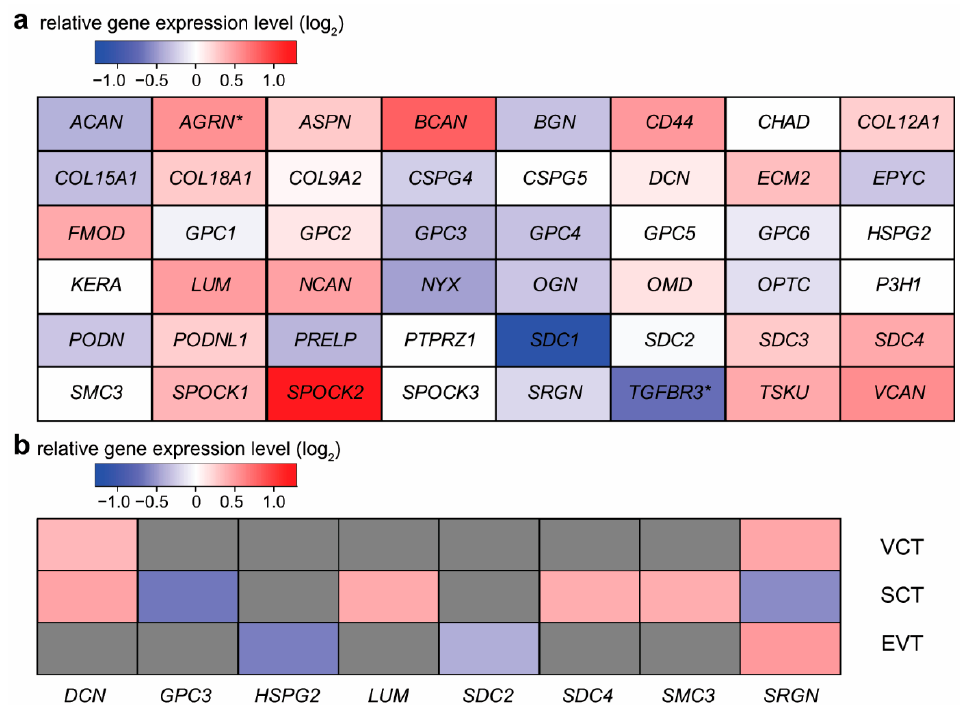
Figure 6. Placental proteoglycan gene expression in pre-eclampsia. ( a ) Placental microarray data from women with early-onset pre-eclampsia (n = 12) and preterm controls (n = 5) were published by Than et al. [51]. Color code depicts log 2 gene expression ratios between cases and controls. Red indicates higher gene expression, while blue depicts lower gene expression in pre-eclampsia. Stars show significant differences. ( b ) Single-cell RNA-seq data from women with early-onset pre- eclampsia and preterm controls were published by Zhang et al. [70]. Differentially expressed genes in villous cytotrophoblasts (VCT), in the syncytiotrophoblast (SCT), and in extravillous trophoblasts (EVT) were visualized on a heatmap. Red indicates higher gene expression, blue depicts lower gene expression in pre-eclampsia (log 2 fold change, q-value < 0.05), and grey depicts non-differentially expressed genes.